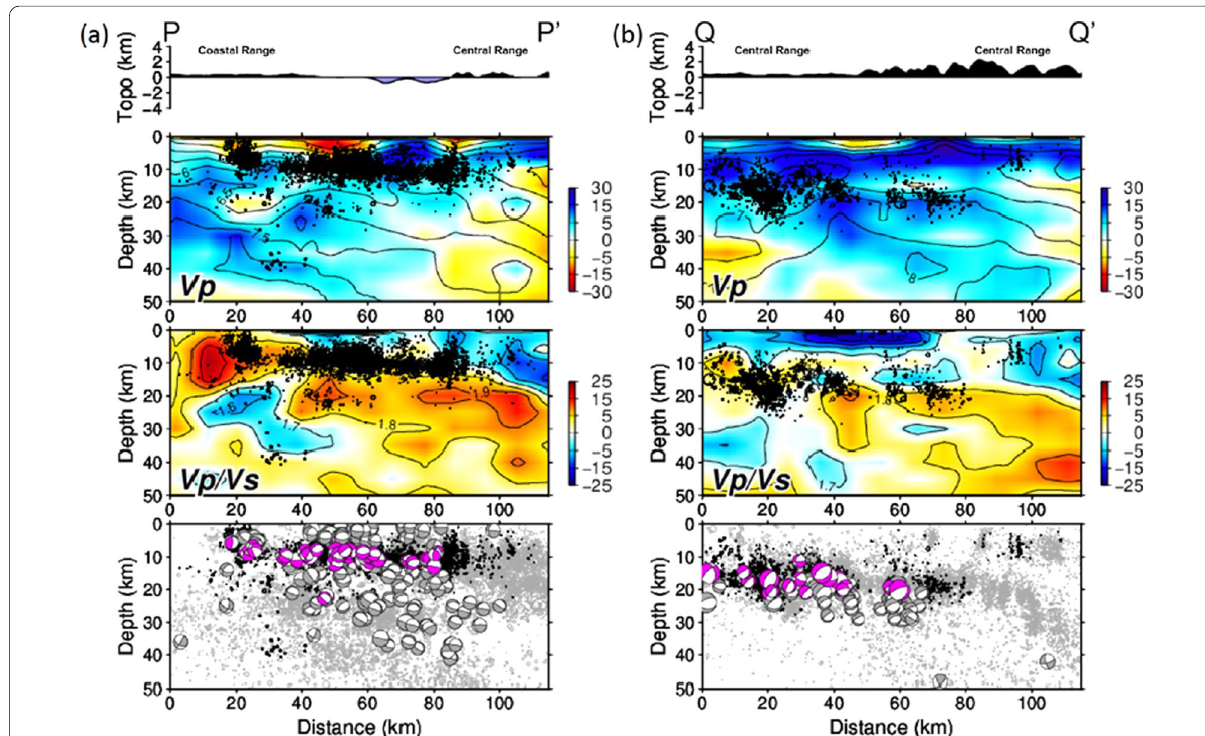
Fig. 7 Approximately N–S direction velocity profiles along the Longitudinal Valley. The strike of these profiles is paralleling to major faults’ orientations. See maintext for detailed discussion. The gray circles and gray beachballs are the relocated hypocenter of background seismicity and focal mechanisms from AutoBATS (Jian et al. 2018). The black circles and purple beachballs are the relocated hypocenter and redetermined first‑motion focal mechanism of the 28 earthquake clusters. The profile location is shown in Fig.